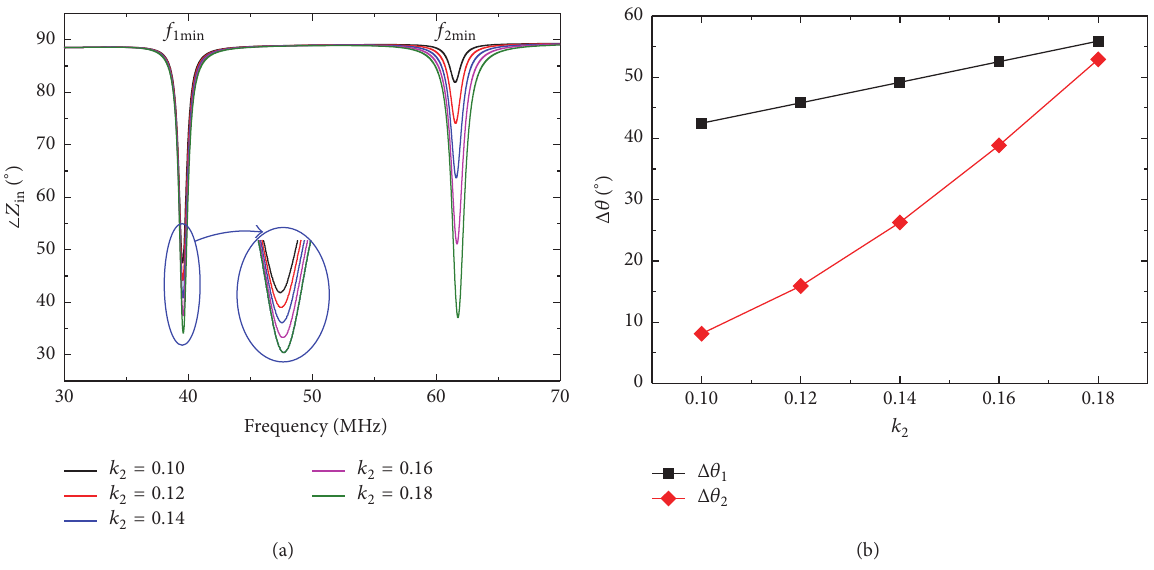
Figure 9: (a) Phase versus frequency curve of the readout coil when the coupling coefficients 𝑘 2 increased and (b) the influence of 𝑘 2 on the value of Δ𝜃 1 and Δ𝜃 2 .